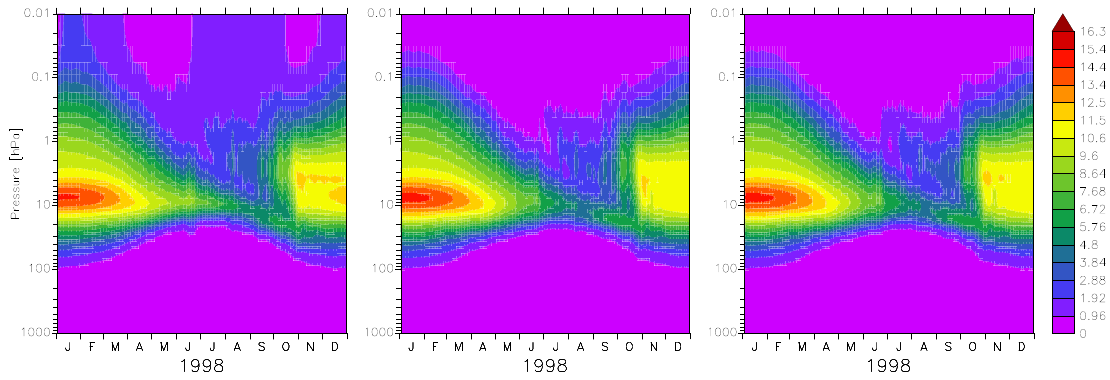
Fig. 3. Same as Fig. 2 but for NO x (nmol/mol) for the zonal average at 60 ◦ S–90 ◦ S.